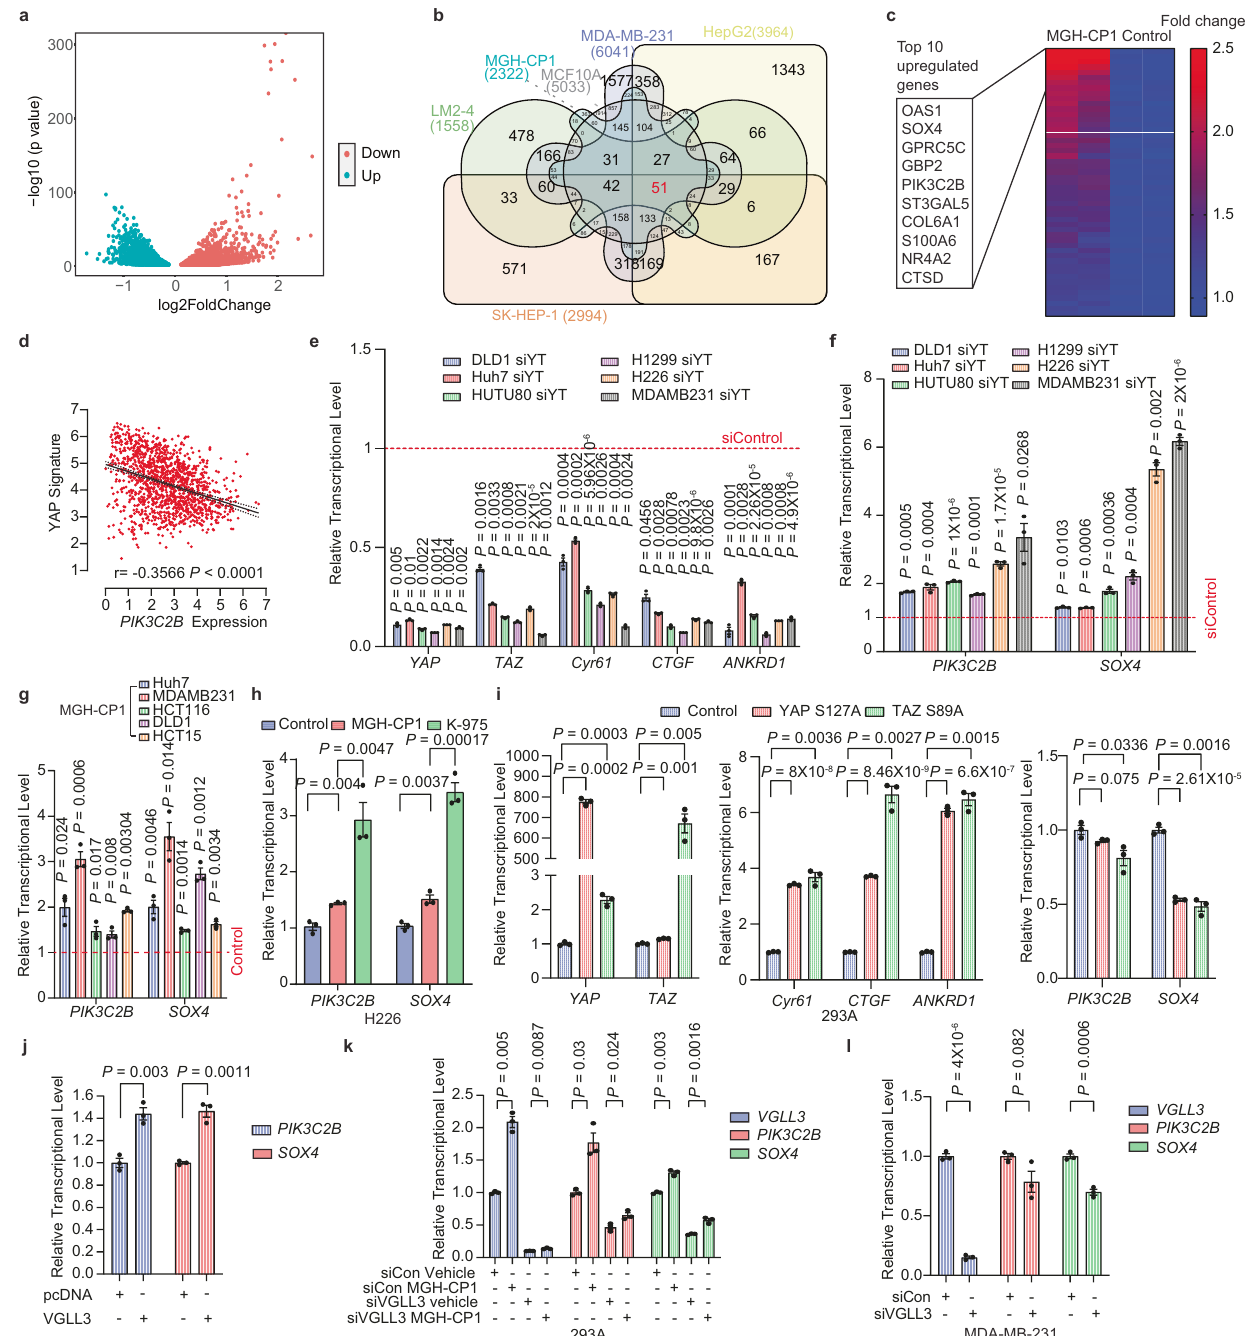
Fig. 4 | TEAD – YAP/TAZ blockade promotes transcriptional activation of PIK3C2B and SOX4 mediatedbyVGLL3.a VolcanoplotofRNA-seqresultsofMDA- MB-231 cells treated with MGH-CP1. b Venn diagram of signi fi cantly upregulated genes treatedwithMGH-CP1and siYAP/TAZ in various cancercelllines. c Heatmap of 51 genes commonly upregulated with TEAD – YAP/TAZ blockade. Top 10 genes with the highest fold change were shown in the box. d Pearson correlation of PIK3C2B transcriptional level against YAP signature in tumor cells. Transcriptional level of YAP, TAZ, Cyr61, CTGF, ANKRD1 ( e ), PIK3C2B and SOX4 ( f )wereexaminedin DLD1, Huh7, HUTU80, H1299, H226 and MDA-MB-231 cells with siYAP/TAZ knockdown. All the gene expression levels of siYAP/TAZ treated samples were normalized to siControl (dashline). ( n =3 biological repeats). siYT, siYAP/TAZ. g PIK3C2B and SOX4 transcriptionallevelsinHuh7,MDA-MB-231,HCT116,DLD1and HCT15 treated with MGH-CP1 treatment were assessed by qPCR ( n =3 biological